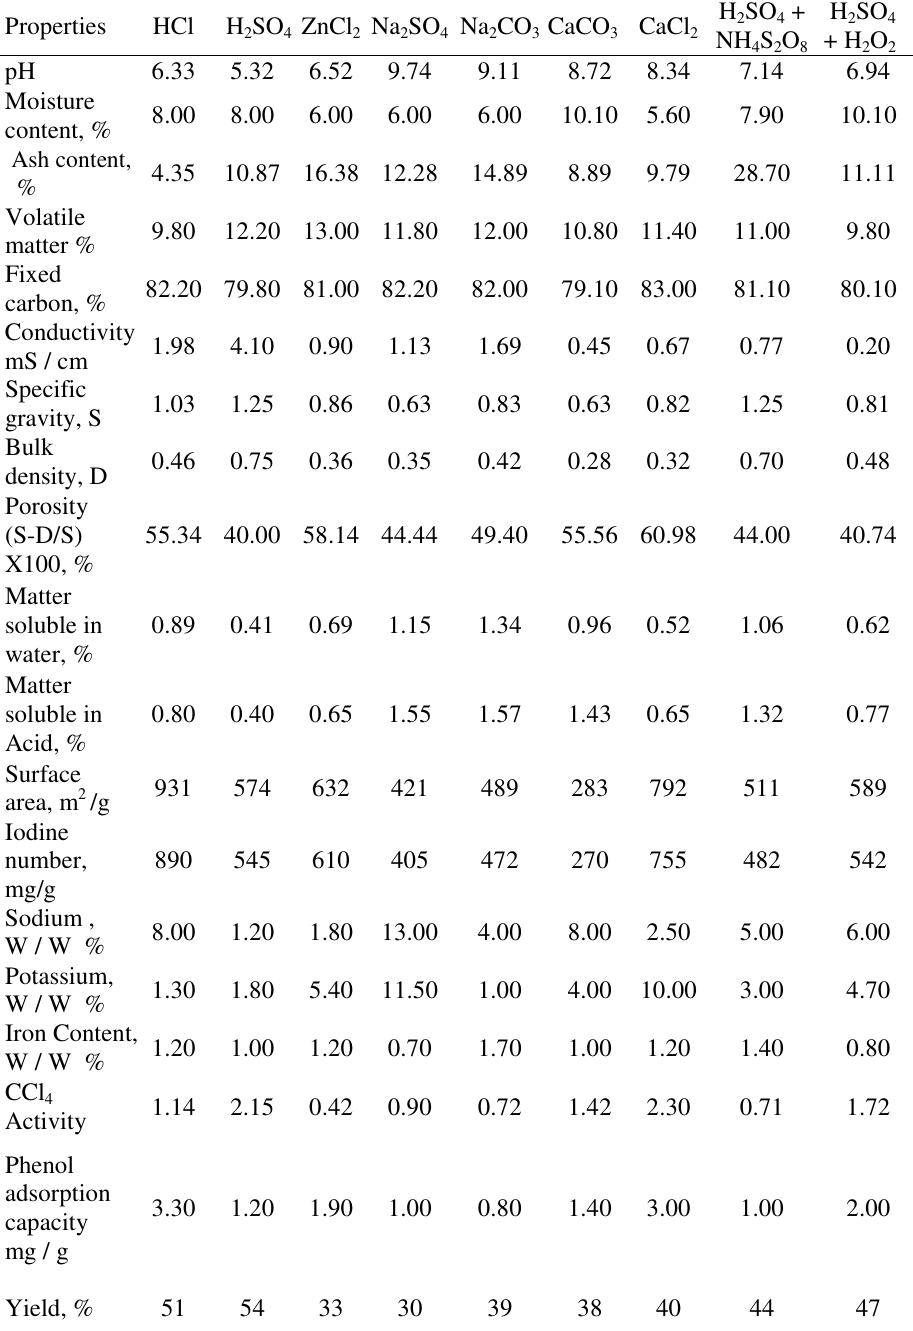
Table 4 Ferronia seed shell waste activated carbon